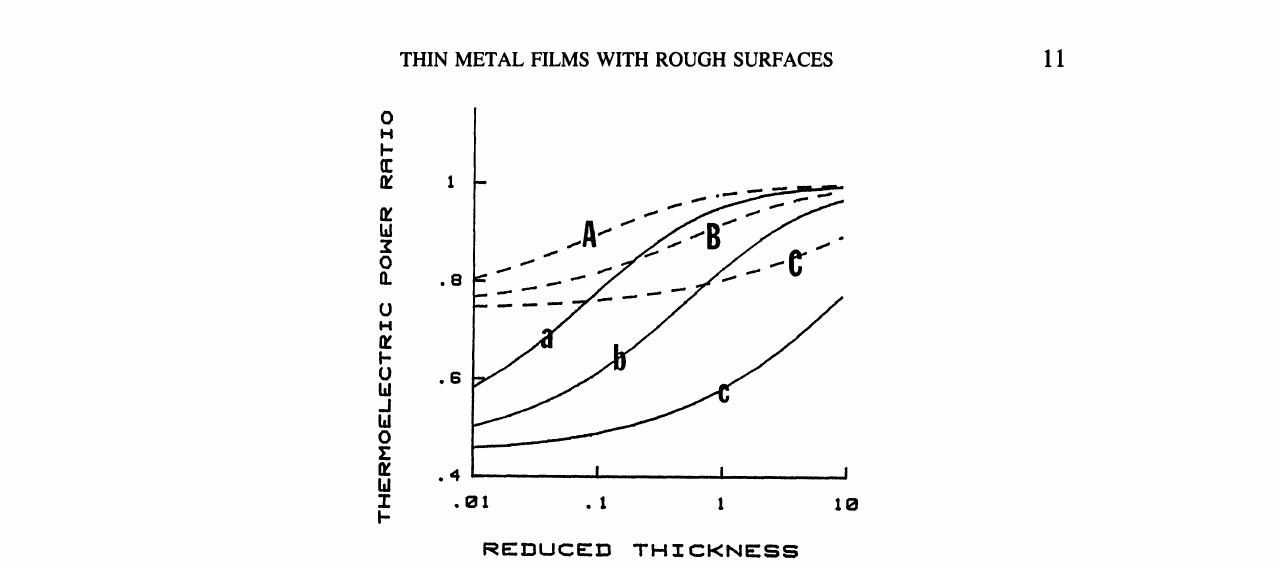
5 eV and for different values of rn and r/he. Curves A, B, C are for rn -3 and for r/hc 0.04, 0.1 and 0.4 respectively. Curves a, b, c are for rn 3 and for r/k 0.04, 0.1 and 0.4 respectively.